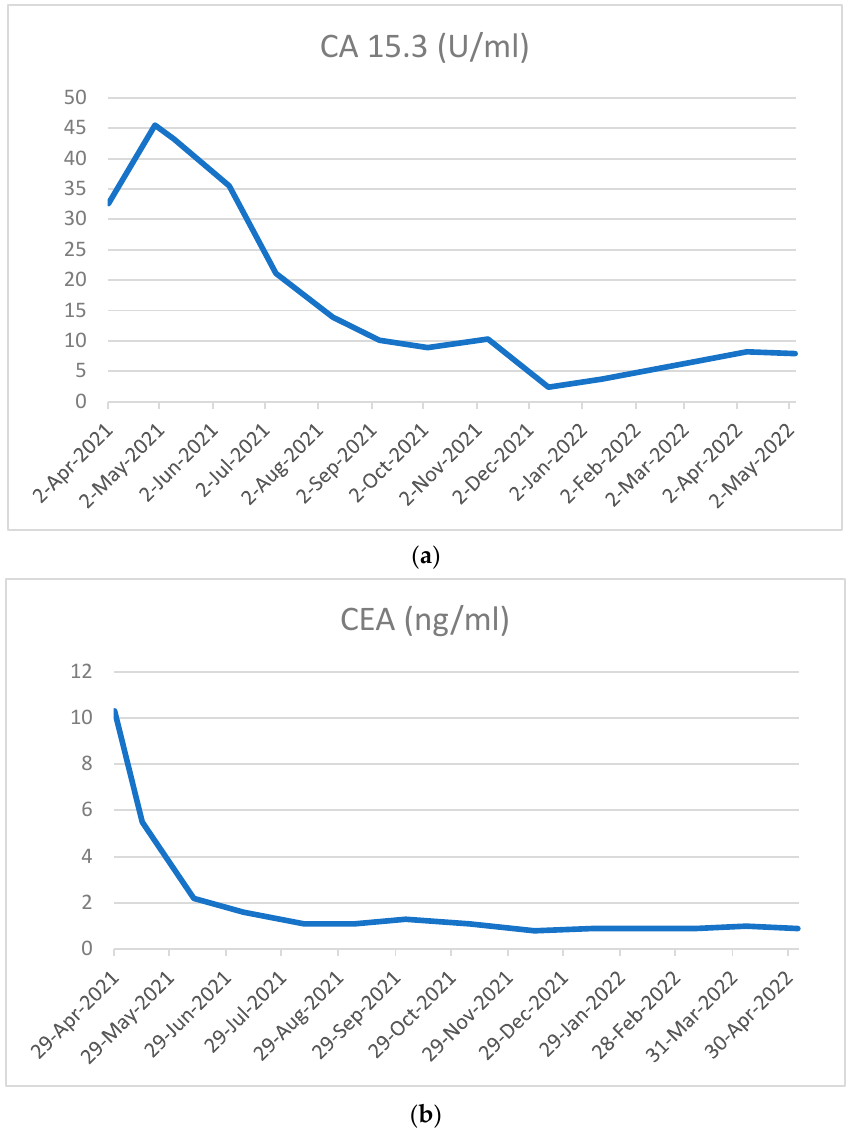
Figure 4. Trend of CA15.3 ( a ) and CEA ( b ) over time.